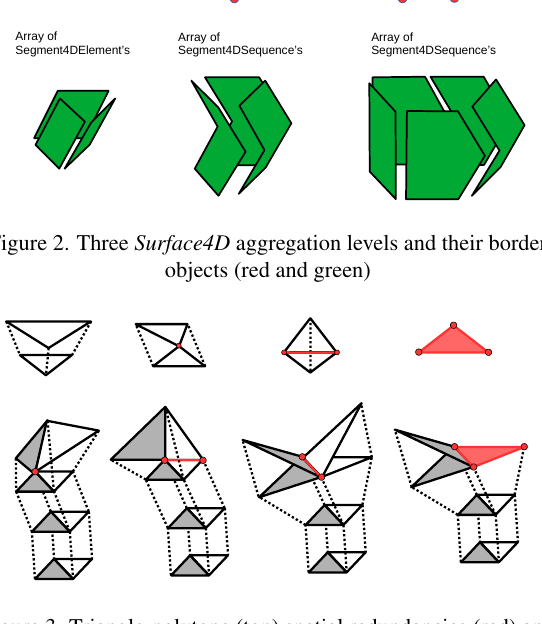
Figure 1. Spatio-temporal geometry types (Jahn and Bradley, 2021)